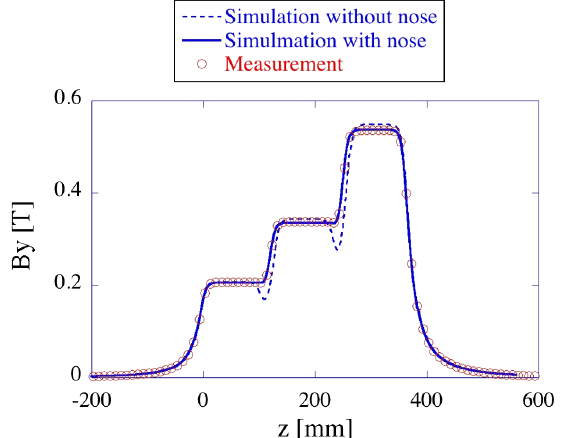
FIG. 7. Longitudinal field distributions with (blue, solid) and without (blue, dashed) nose structures by numerical simulations, and the measurement result (open circles).